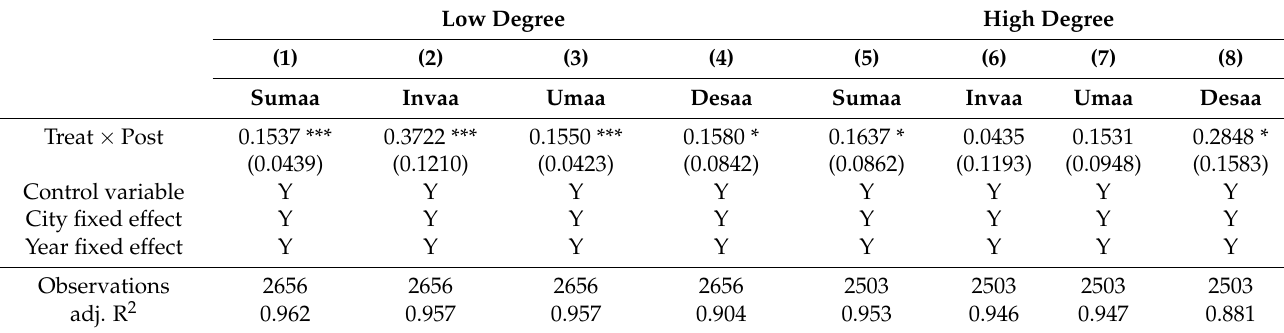
Table 10. Regression results of urban business